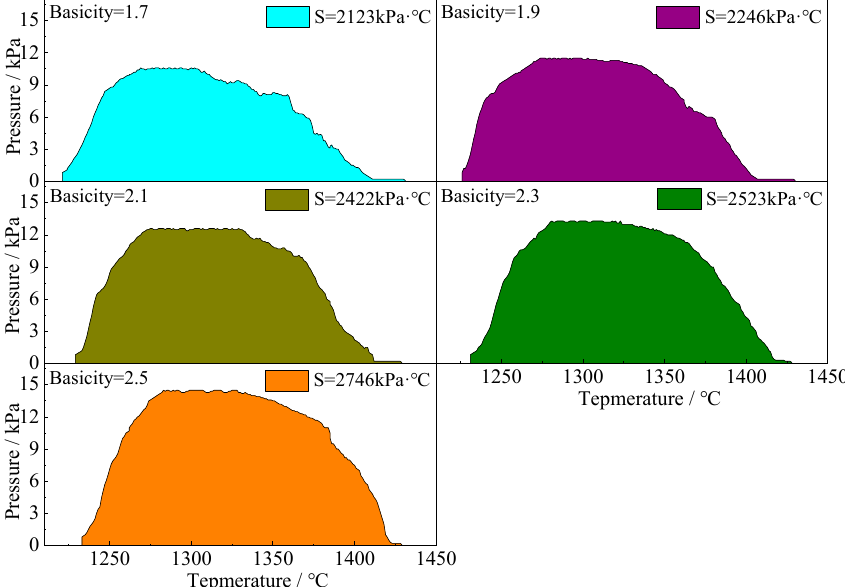
ff ect of basicity on the gas permeability of HCVTM Figure 11. Effect of basicity on the gas permeability of HCVTM sinters. Figure 11. E